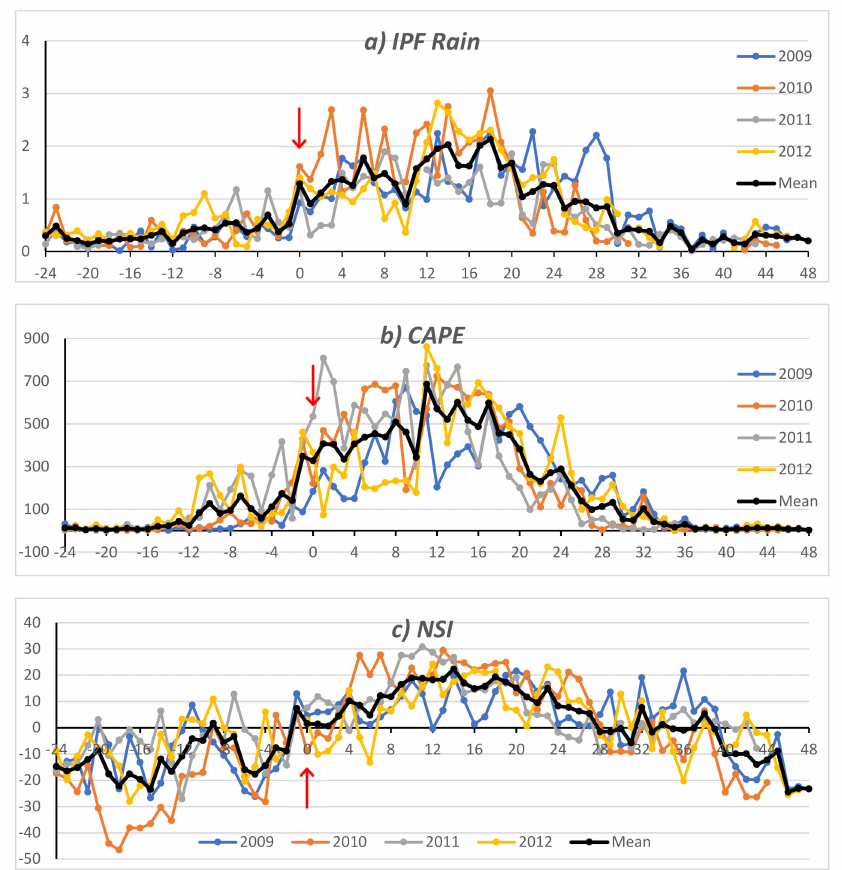
Figure 1. Pentad timeseries of ( a ) IPF rain (mm day − 1 ), and North American Regional Reanalysis (NARR), ( b ) convective available potential energy (CAPE) (J Kg − 1 ) and ( c ) North–South Index (NSI) (m s 1 ). All timeseries are averaged over the SE US land domain southward of 40 ◦ N and eastward of 90 ◦ W. Time is shown in terms of pentads prior to (negative values) and after (positive values) IPF onset, with IPF onset at t = 0 (red arrow). The 4-year average timeseries for each variable is also shown (black